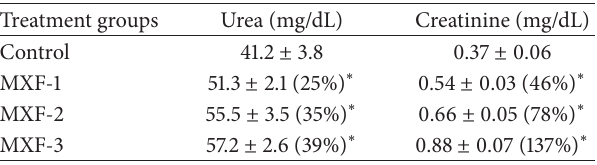
Table 1: Influence of MXF on plasma biomarkers of renal toxicity in